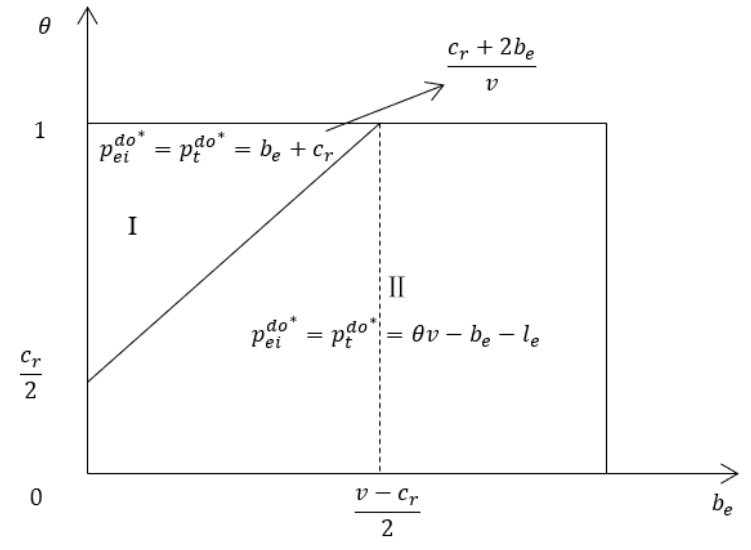
Figure 5. Stackelberg equilibrium prices under the BOPS strategy.